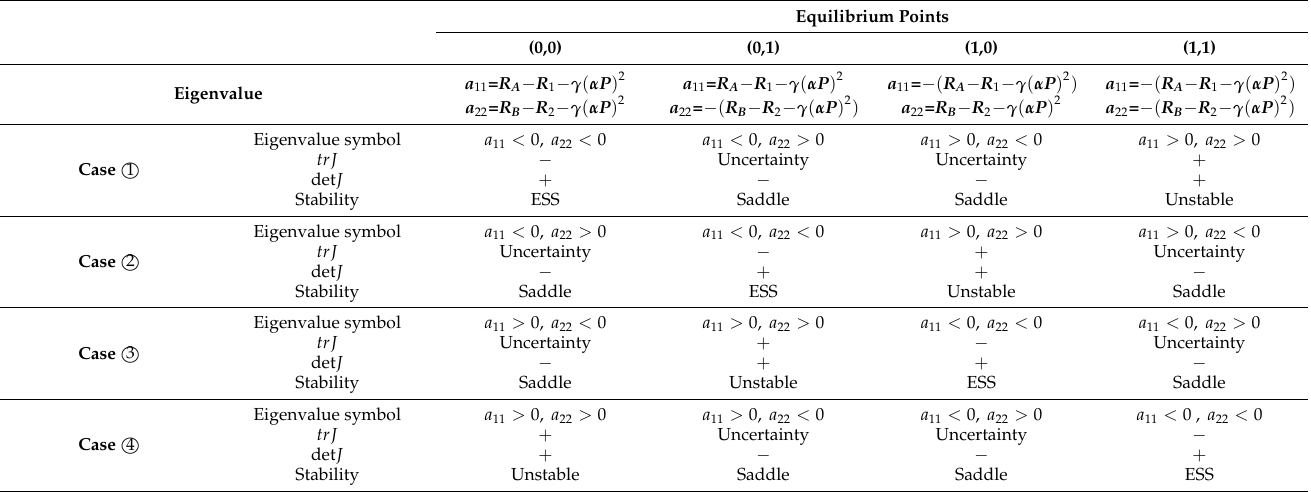
Table 3. Stability analysis of the system equilibrium point under different